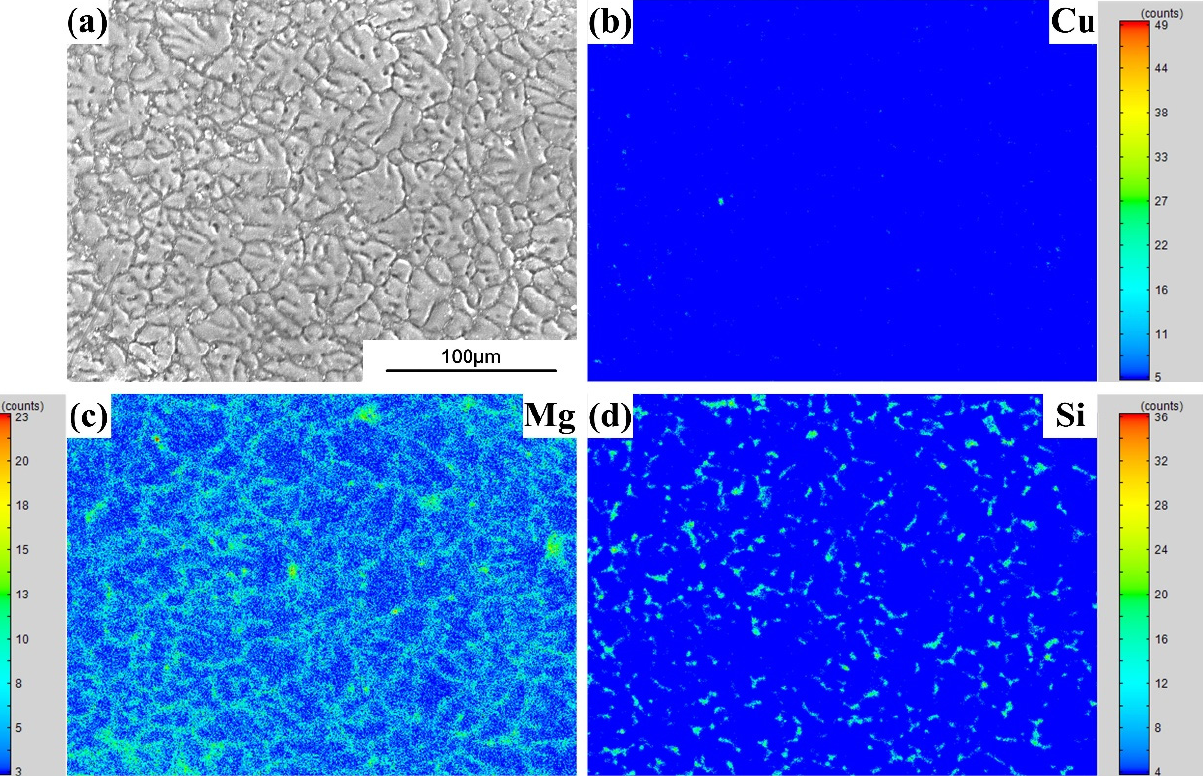
Figure 10. The EPMA mapping results (the AA7075/Al-Cu 4.5 -Si 1.5 weld): ( a ) Secondary electronic image; ( b ) Cu distribution; ( c ) Mg distribution; ( d ) Si distribution.